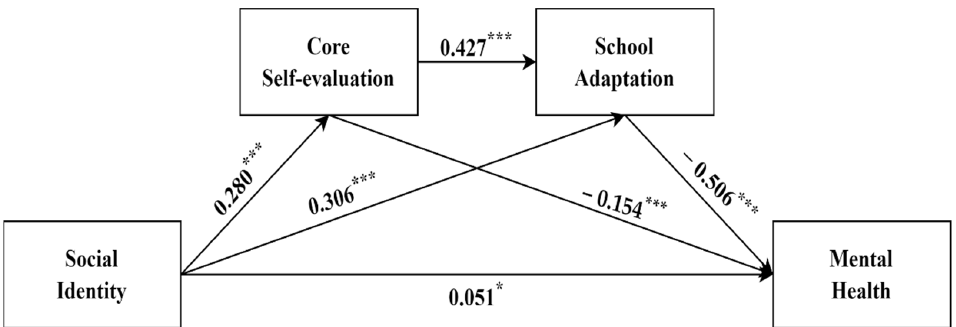
Figure 1. Diagram for the study variables association. *** p < 0.001. * p < 0.05.